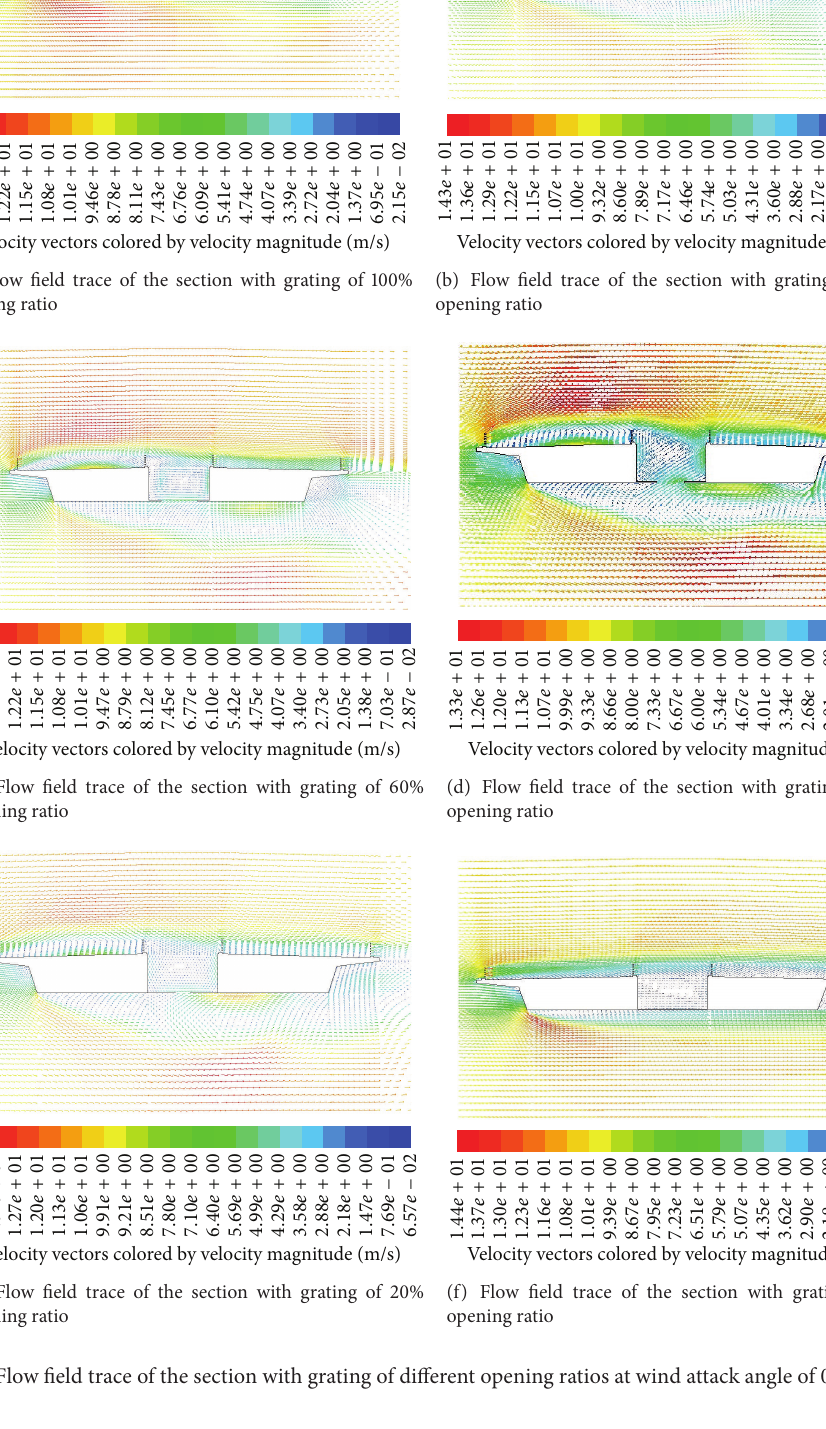
Figure 10: Flow field trace of the section with grating of different opening ratios at wind attack angle of 0 deg.